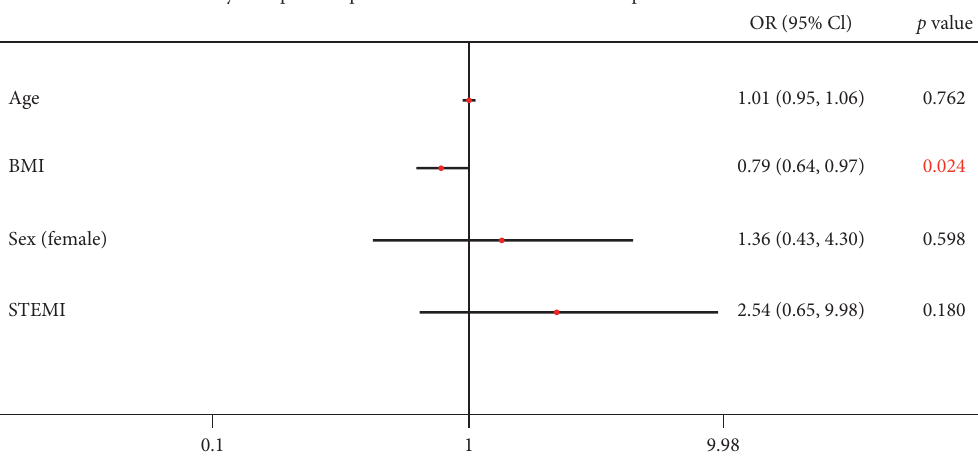
Multivariate analysis of possible predictors of cannulation failure in patients with dTRA